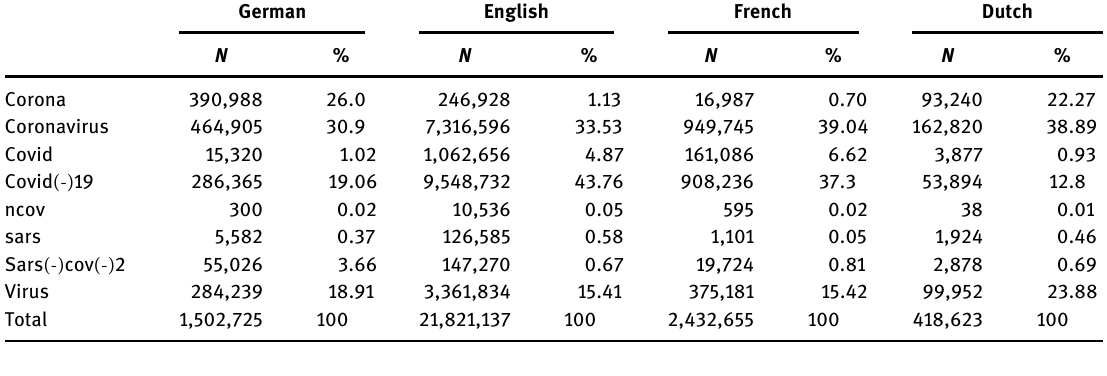
Table 4: Total number of seed terms per language in the newspaper corpus, in absolute ( n ) and relative ( % ) frequency German